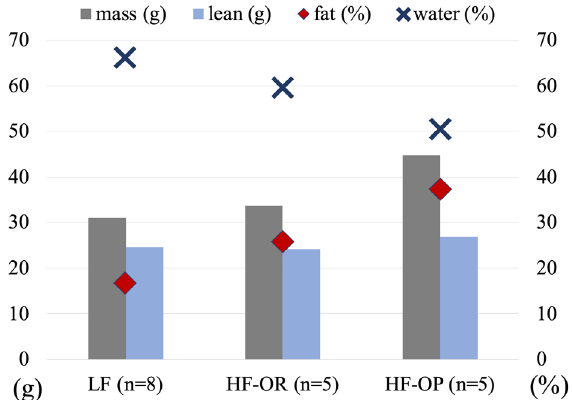
Figure 2. The average body-weight (g), fat percentage, body-water percentage and lean content (g) for the low fat (LF) mice group, high fat obesity-resistant (HF-OR) mice group and high fat obesity-prone (HF-OP) mice group.